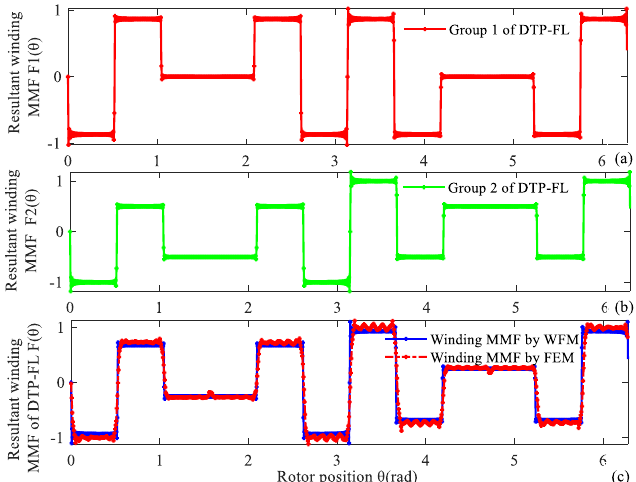
Figure 13. Resultant winding MMF of 12-slot/10-pole DTP-FL winding at time t = 0 s. ( a ) First group of TP winding, ( b ) second group of TP winding, ( c ) two groups of TP winding.